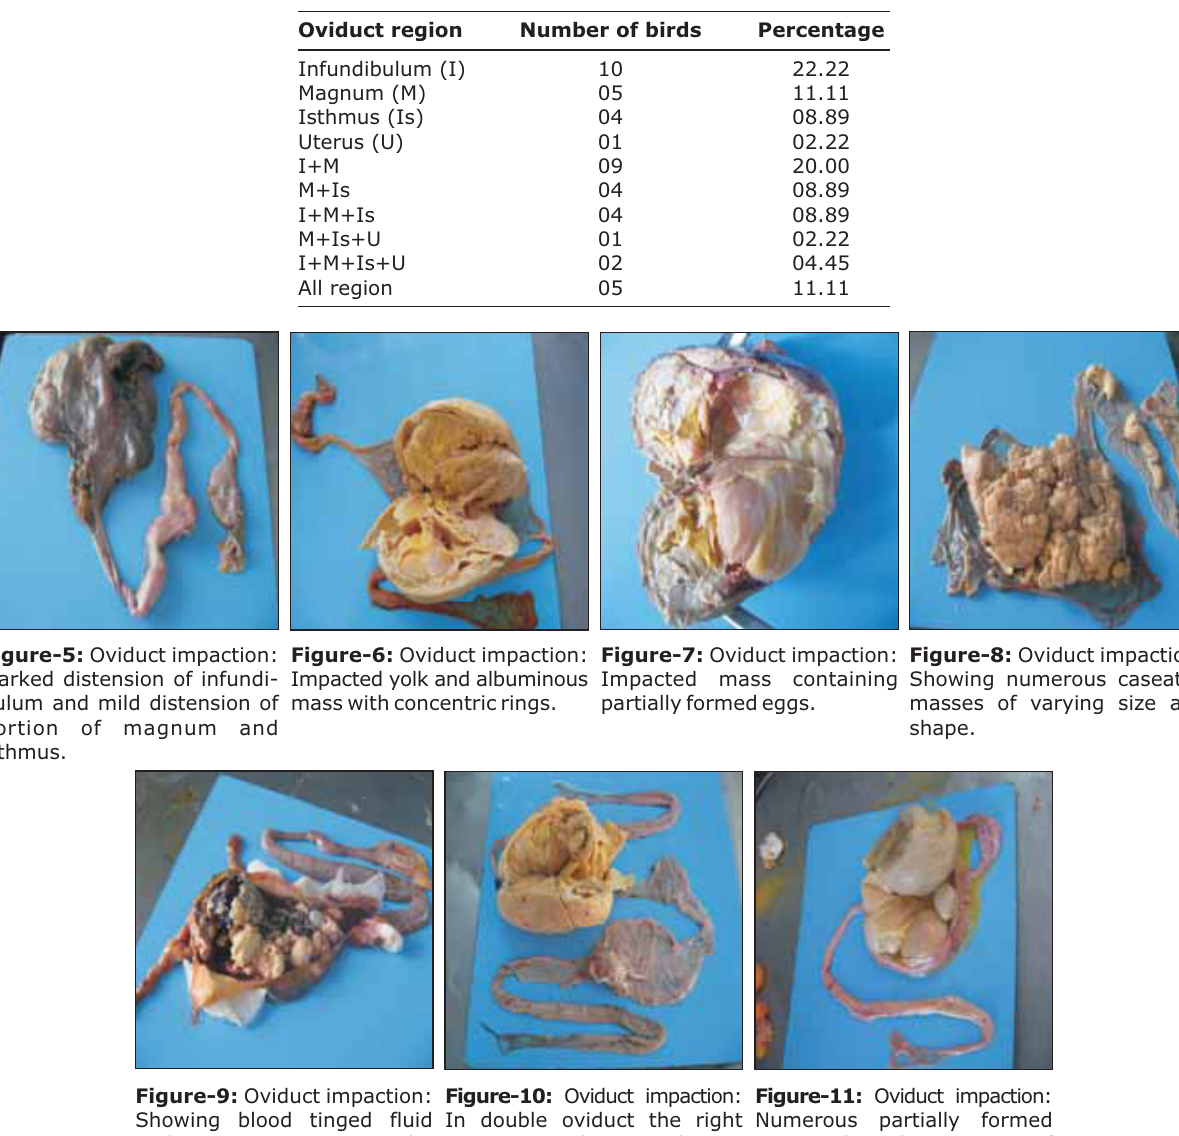
Figure-11: Oviduct impaction: Numerous partially formed eggs in the isthmus region of the